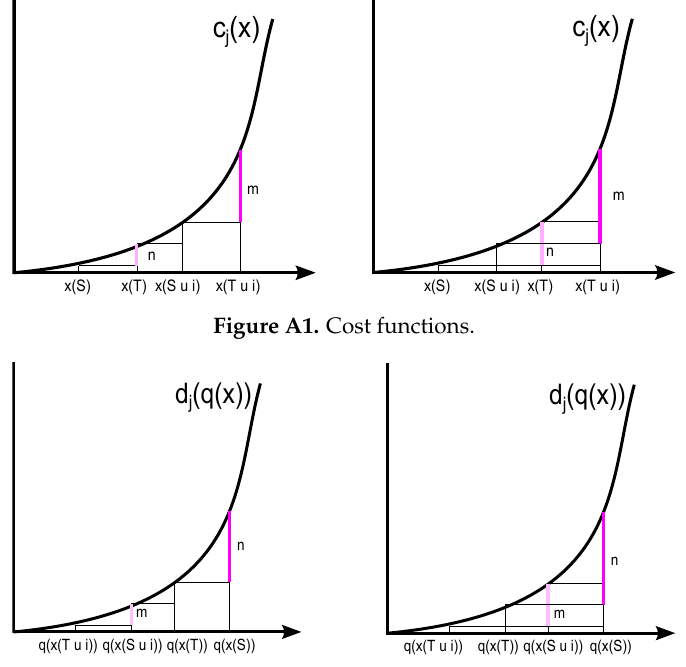
Figure A1. Cost functions.